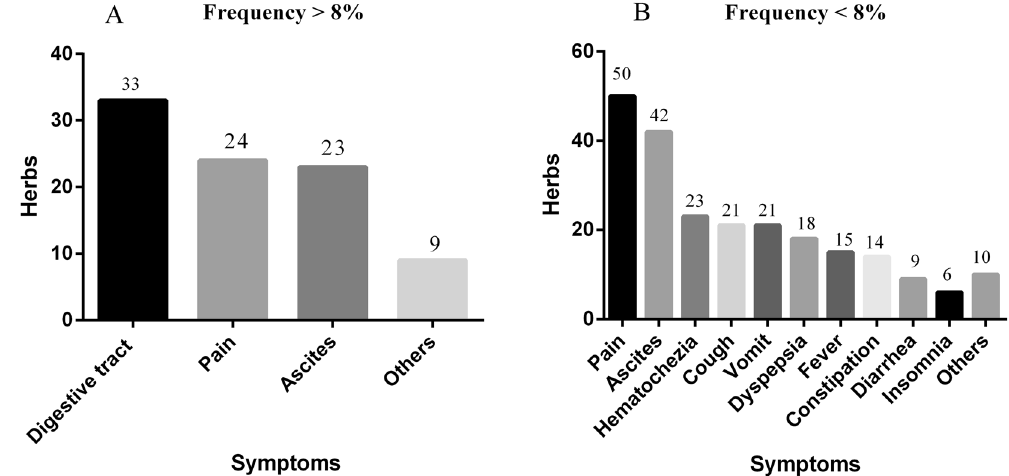
Figure 4. Analysis of the herbs unrelated to survival. ( A ) Seventy-four commonly used herbs unrelated to survival were applied to relieve the major complications of CRC mainly through relieving pain, diuresis and alleviating digestive tract symptoms. ( B ) 203 herbs uncommonly used herbs were administered to relieve various uncomfortable